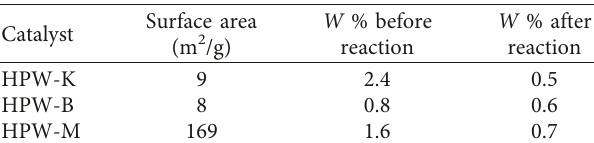
Figure 5: Reuse of supported HPW catalysts for the esterification of acetic acid with heptanol in the presence of (a) HPW-K, (b) HPW-B, and (c) HPW-M, and (d) data shown in the form of table. Table 4: Surface area and elemental analysis of tungsten ( W ) in the catalyst for esterification of acetic acid with